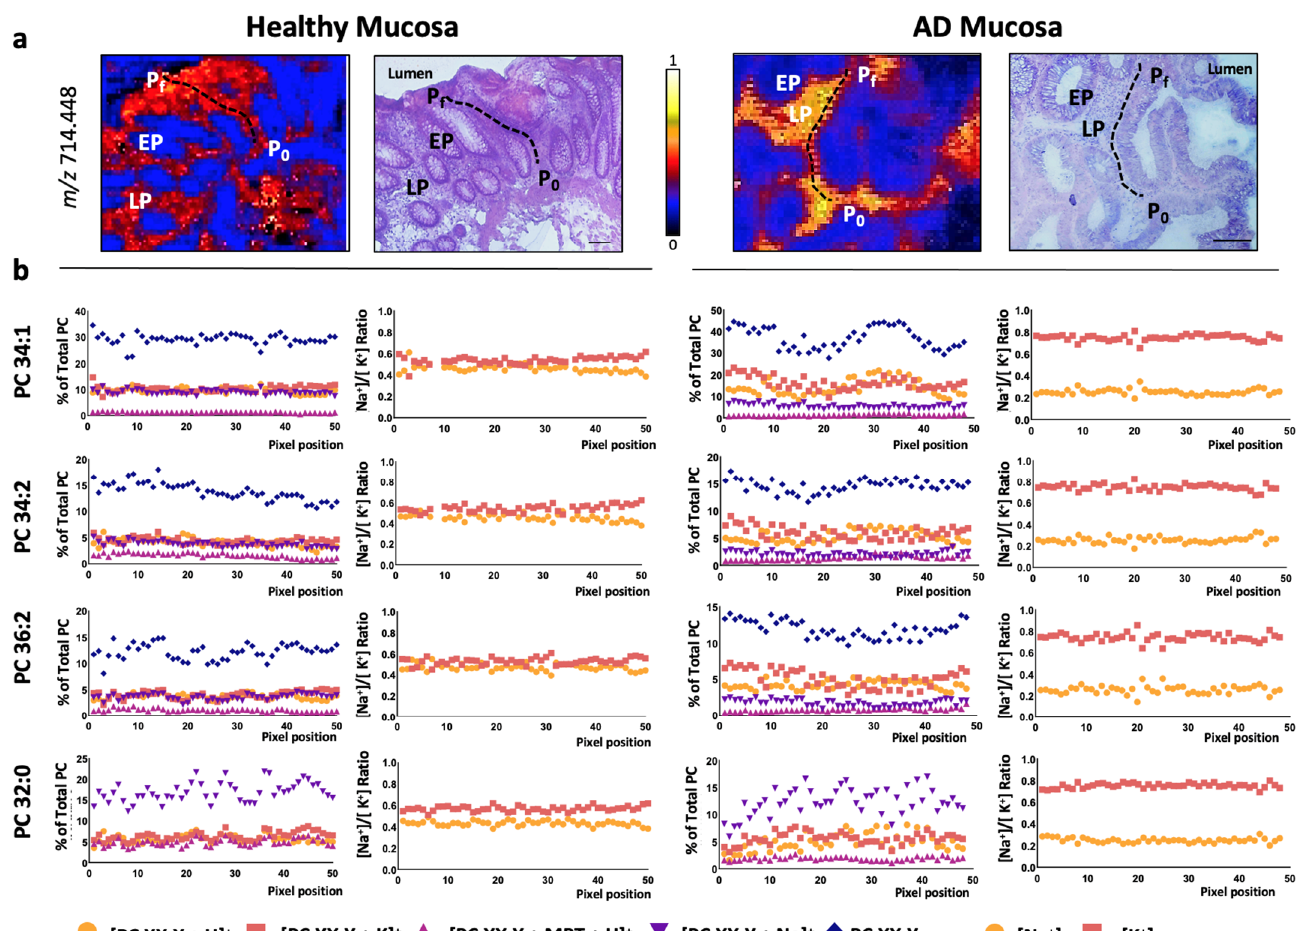
Figure 5. PC adduct distribution in healthy colon and adenomatous polyp lamina propria. ( a ) Selected MALDI-IMS images obtained during the analysis in positive-ion mode (in particular, m / z = 714.448) showing the paths depicted from the basal (P 0 ) to the luminal side (P f ) of the mucosa to analyze, pixel-by-pixel, the changes in the lipidome along the lamina propria in healthy and AD mucosa. Hematoxylin-eosin images of the consecutive sections are included for comparison. Scale bar = 100 µm. ( b ) Individual distribution of PC adduct along the depicted paths and the [Na + ]/[K + ] ratio for selected PC species (PC 34:1, PC 34:2, PC 36:2, and PC 32:0). The rest of the species (PC 36:1, PC 36:3, PC 36:4, and PC 38:4) may be found in Figure S4. EP: epithelium; LP: lamina propria; P 0 : first pixel of the path; P f : final pixel of the path.